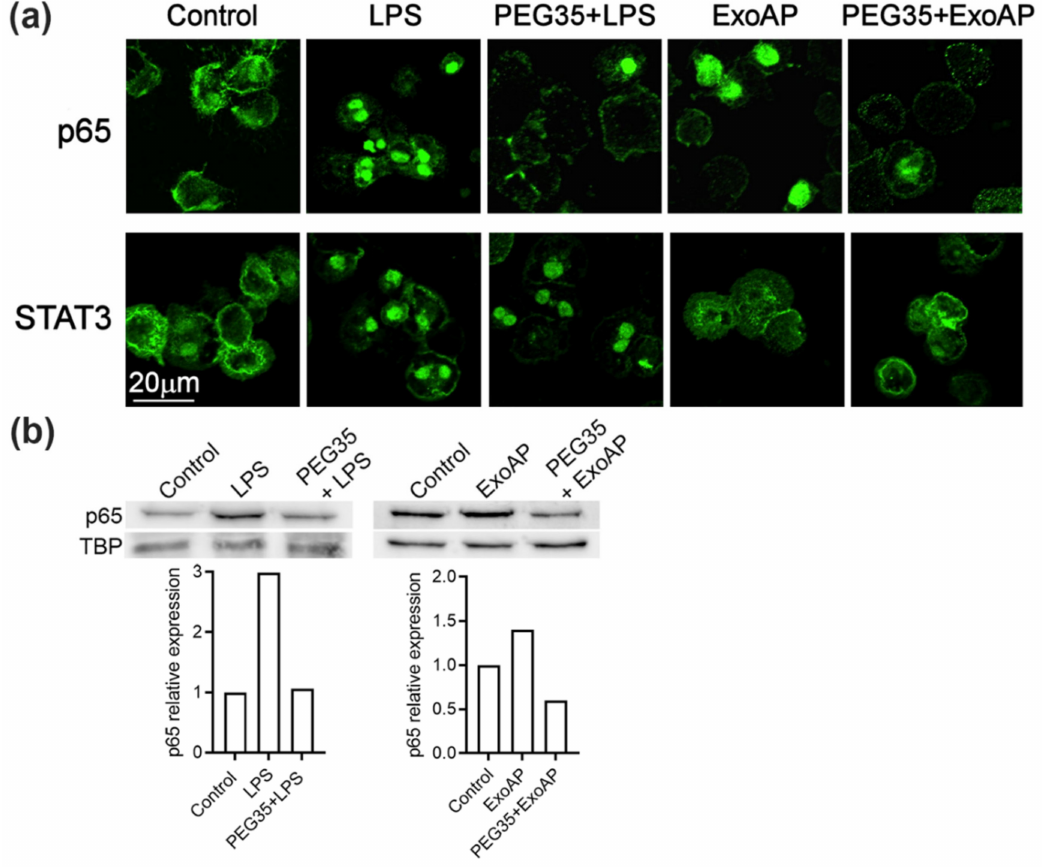
Figure 5. PEG35 suppressed p65 translocation to the nucleus in LPS or ExoAP-stimulated macrophages: ( a ) representative images of immunofluorescence staining for subcellular localization of the p65 subunit of Nuclear Factor Kappa B (NF κ B) and Signal transducer and activator of transcription 3 (STAT3) observed by confocal microscopy, with scale bar 20 µ m, and ( b ) nuclear expression of p65 assessed by Western blot analysis. TBP expression was used as the loading control. Densitometry quantification of the Western blot was performed for p65. Data are representative of several repeated experiments. LPS, lipopolysaccharide; ExoAP, exosomes from AP-induced rats; PEG35, 35-kDa polyethylene glycol; and TBP, TATA binding